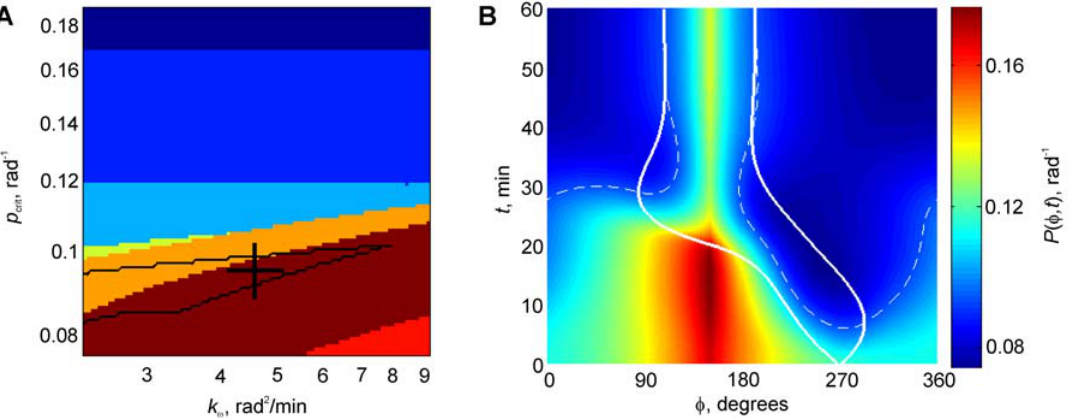
Figure 4. Model behavior when the recycling point is separated from the contact initiation point by 120 u . ( A ) Domains of the parameter space that determine qualitatively different dynamic scenarios. Color coding is the same as in Fig. 2a and 3a, with the additional regime denoted brown : in this novel regime, the contact area not only stabilizes at . 30 u arc in size, but also covers the point of recycling no later than in 30 min. The domain outlined in black is the same as in Fig. 3a, representing the parameter combinations that predicted model behavior compatible with our previous experiments. Note that the domain predicting the novel behavior ( brown ) overlaps with the domain compatible with the previous experiments ( black outline ). Cross denotes the parameter combination for the dynamic example shown in panel B , which is the same parameter combination as for the examples in Fig. 2b and 3b. ( B ) Dynamics of the surface TCR distribution and contact boundaries. The plotting conventions are the same as in Fig. 2b and 3b. Recycling is directed to w =150 u , and the contact is initiated at w =270 u , which positions are separates by 120 u along the TC